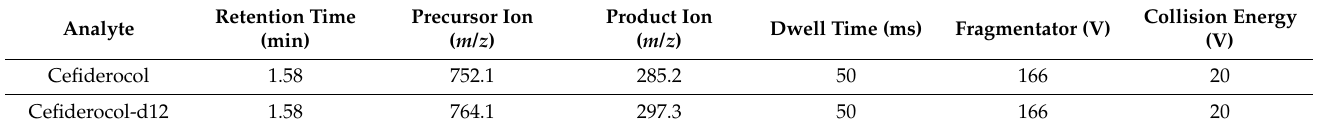
Table 1. Specific MRM transition parameters used for Cefiderocol and Cefiderocol-d12 (IS) acquisition. Analyte